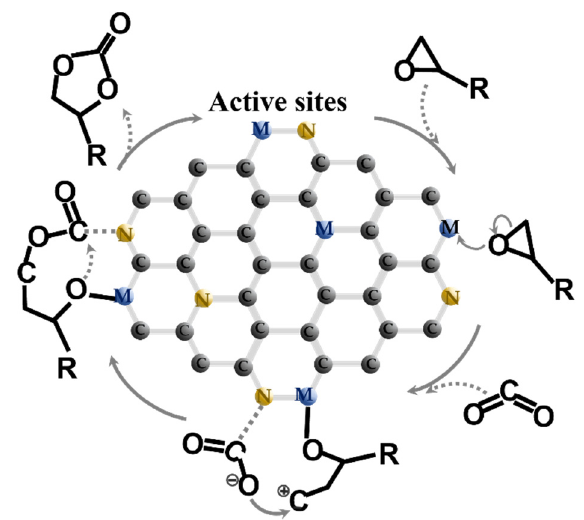
Figure 8. Proposed catalytic mechanism for the cycloaddition of epoxides and CO 2 into cyclic carbonates catalyzed by N-doped porous carbon (M: Acid sites derived from metallic zinc or cobalt, N: Basic sites of N-doped carbon derived from 2-MIM decomposition during pyrolysis).